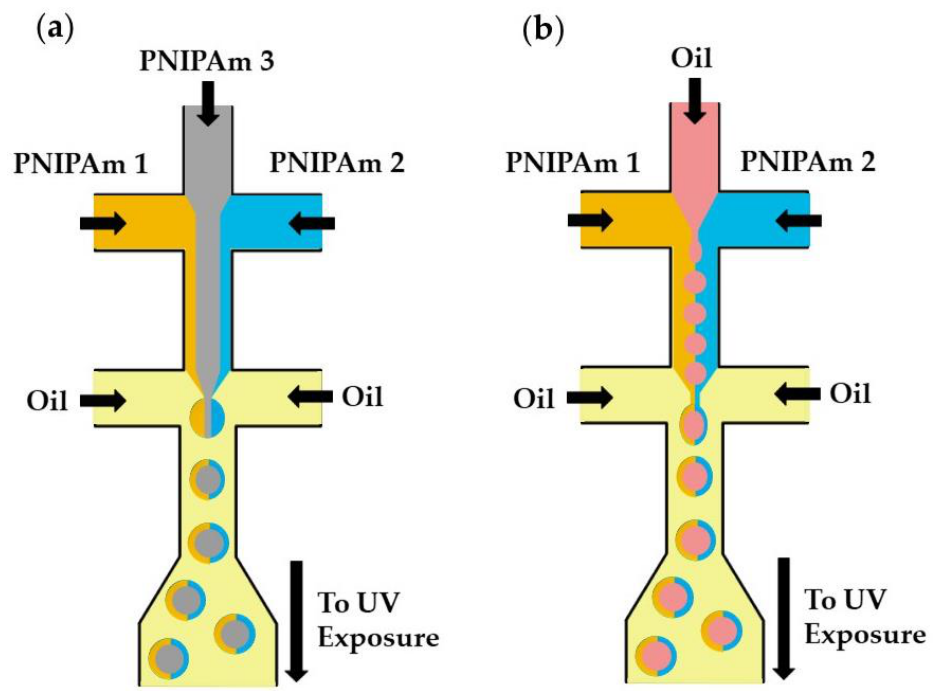
Figure 32. Fabrication of poly(N-isopropylacrylamide) (PNIPAm)-based Janus microgels. ( a ) Solid Janus microgels produced from three distinguishable PNIPAm streams. ( b ) Hollow Janus microgels produced from two distinguishable PNIPAm streams and one inert oil stream